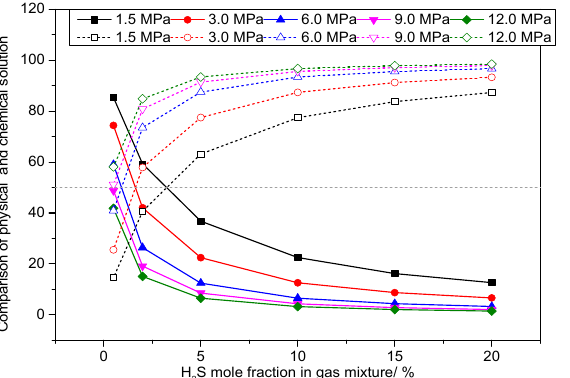
Figure 14. Variation curves of physical and chemical solubility ratios with H 2 S content of gas mixtures. (2) Pressure of 6.0 MPa Figure 15a,b show the variation curves of the physical and chemical solubility as a percentage of the total solubility versus the molar fraction of H 2 S under 6.0 MPa pressure conditions, respectively. The variation pattern of the curves shown in the figure indicated that the increase in the H 2 S concentration had a promoting effect on the chemical dissolu- tion mechanism of elemental sulfur and an inhibiting effect on the physical dissolution mechanism of elemental sulfur. As the molar fraction of H 2 S gradually increased from 0.5% to 20%, the percentage of physical solubility gradually decreased, but the reduction was not always large. Especially when the temperature approached 273.15 K and 333.15 K, the changes in the physical and chemical solubility percentages were less than 10% and 20%, respectively.